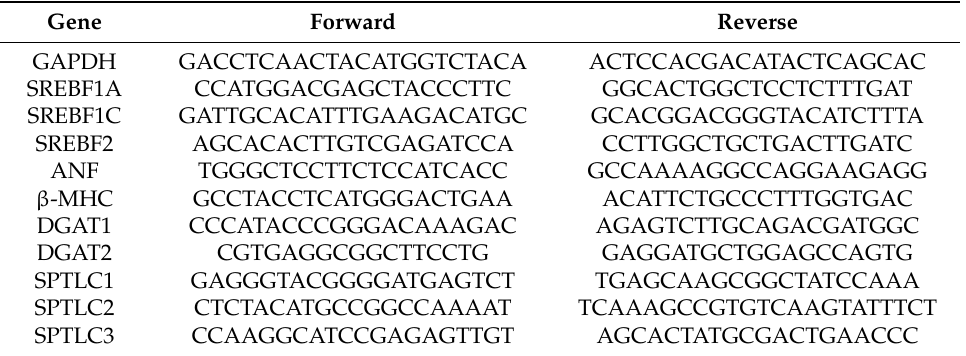
Table 1. Real-Time RT-PCR